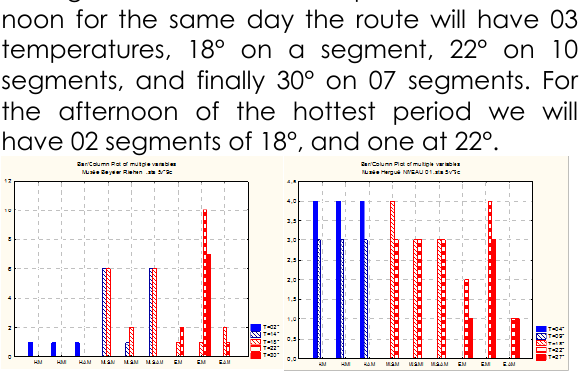
Figure 06: Diagram of variation in number of temperature segments, daily and seasonal variations